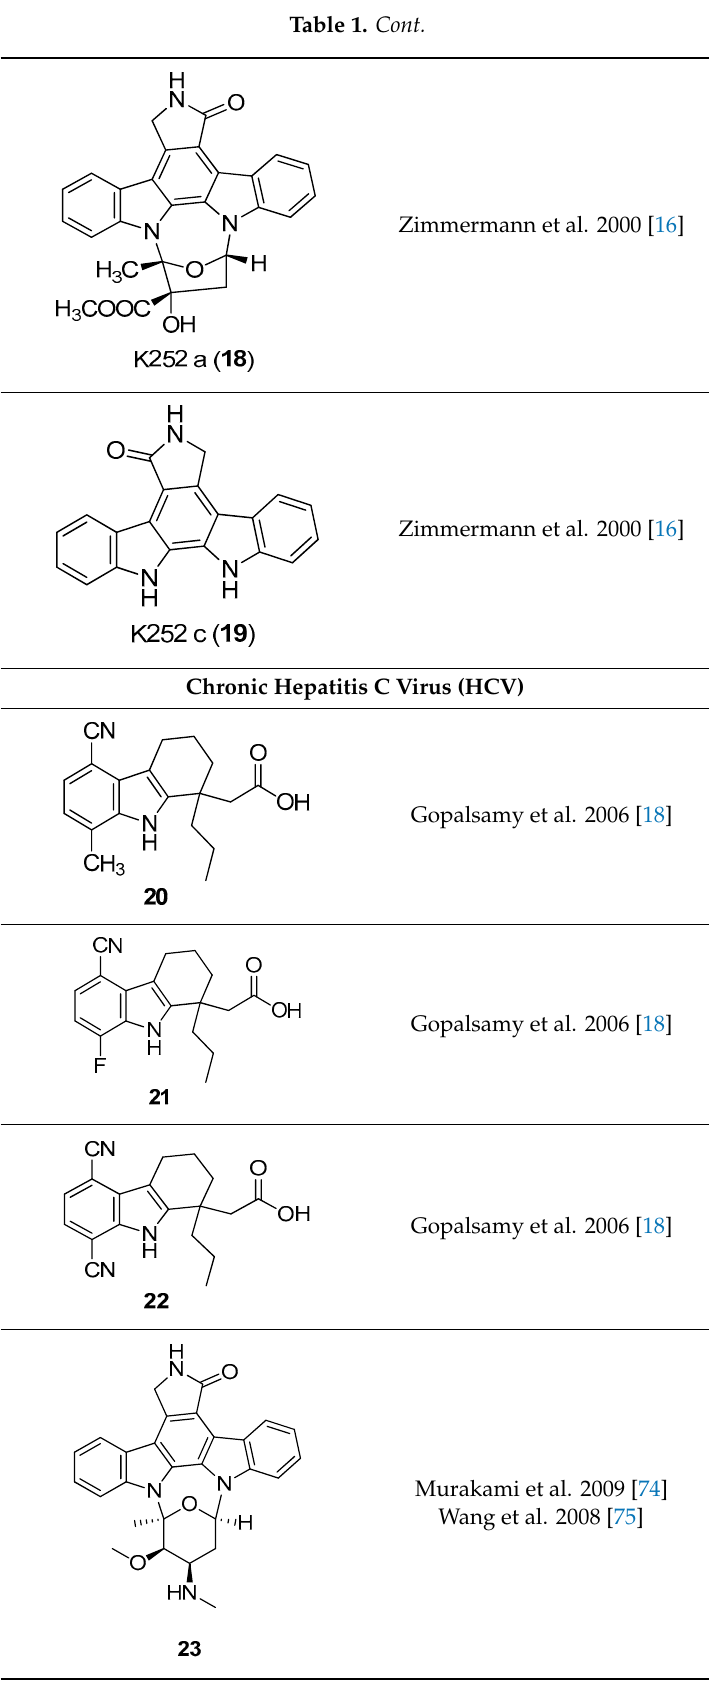
Molecules 2019 , 24 ,